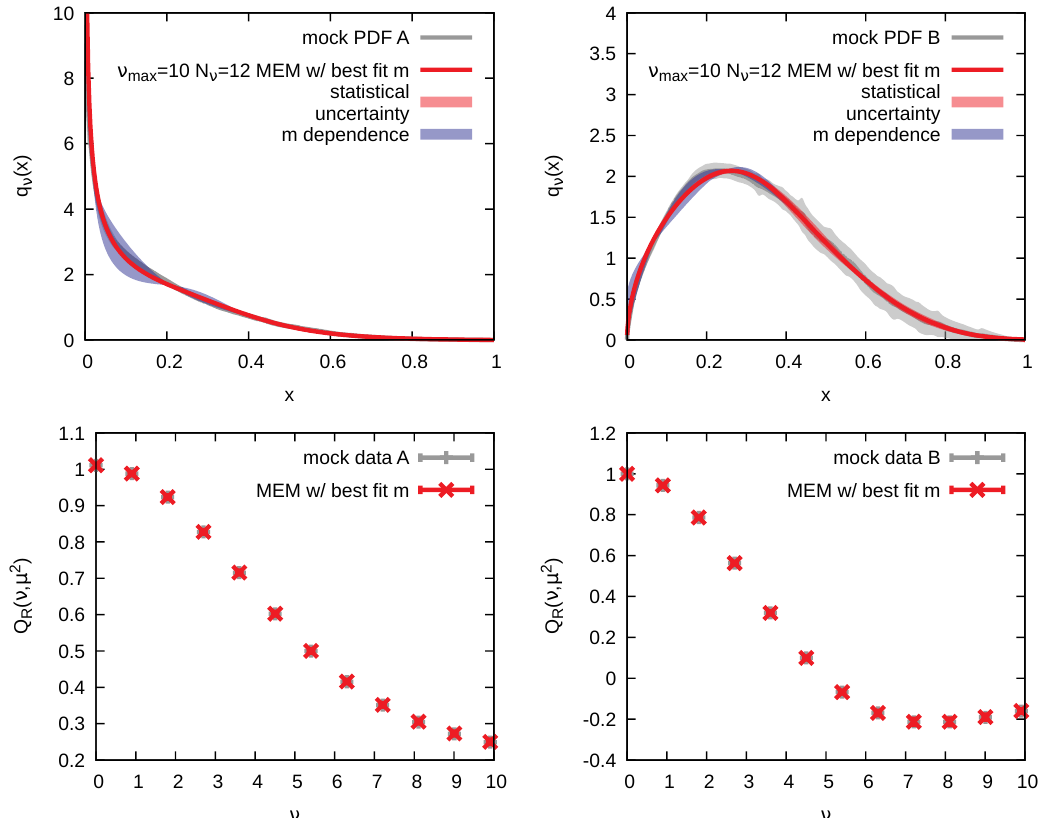
Figure 14 . x -space PDF’s reconstructed using the Maximum Entropy method (MEM) from N (cid:23) = 12 Io(cid:11)e-time data points on the interval (cid:23) = [0 ; 10] (top) as well as the input data (gray crosses) compared to the data arising from the reconstructed PDF (red crosses) in the bottom panels. The plots in the left column denote the results for mock data based on a phenomenological PDF, while the right column from the modi(cid:12)ed scenario where the PDF vanishes at the origin. (top) The original mock PDF is given as gray dashed line and the result based on the MEM method with the best (cid:12)t default model as solid red line. Statistical uncertainty is visualized by a red, systematic uncertainty from the choice of default model by a blue errorband respectively. (bottom) The red crosses denote the Io(cid:11)e-time data obtained from folding the spectral reconstruction with the cosine kernel, the gray data corresponds to the